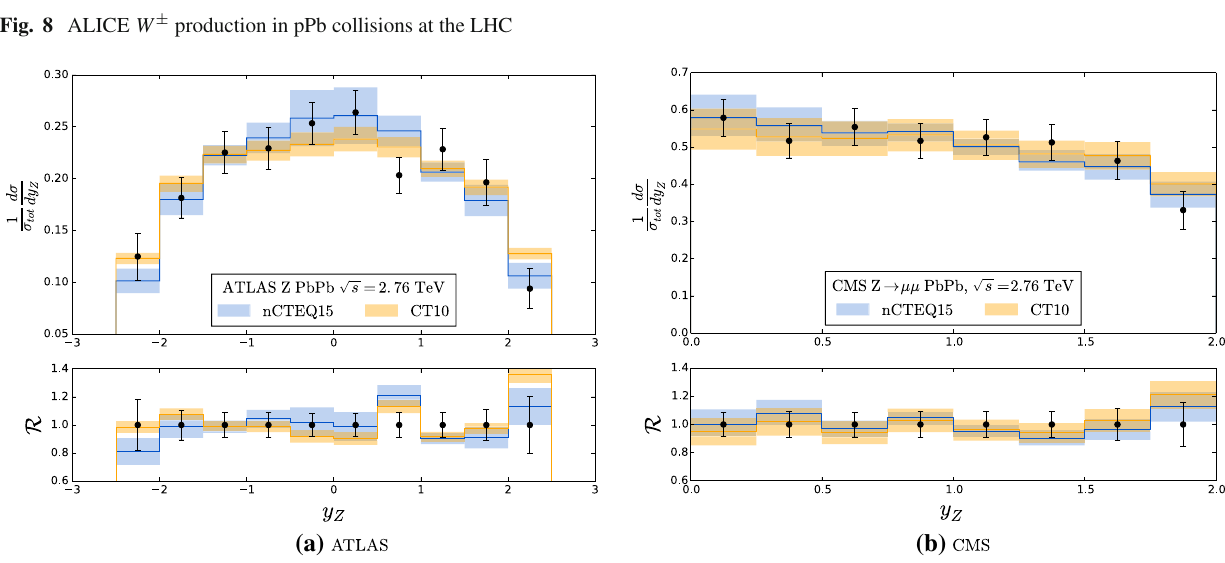
Fig. 9 Z boson production cross section normalized to the total cross section for PbPb collisions at the LHC with the ATLAS and CMS collaborations. Corresponding predictions obtained with nCTEQ15 and CT10 PDFs are also